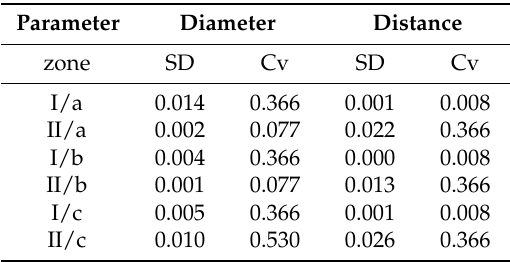
Table 1. Standard deviations (SD) and coefficient variations (Cv) of the diameter and distance value.